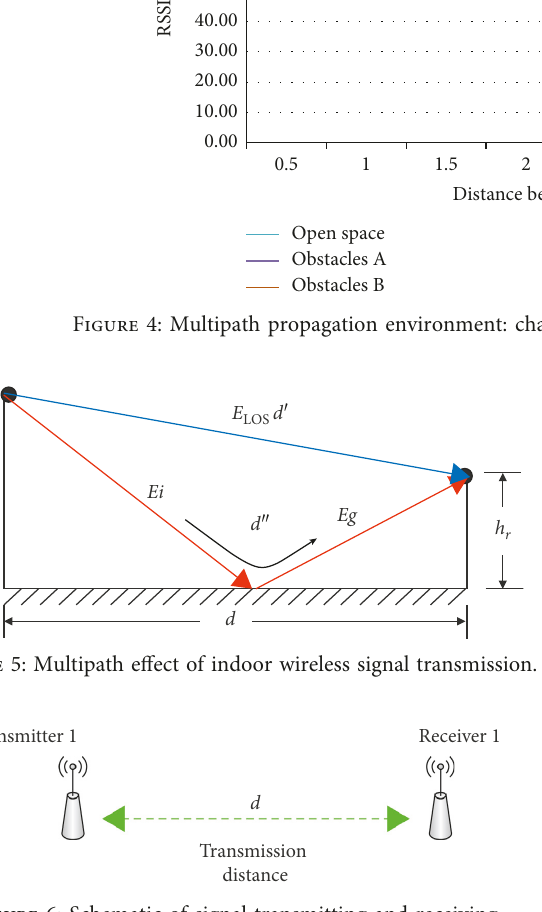
Figure 6: Schematic of signal transmitting and receiving.